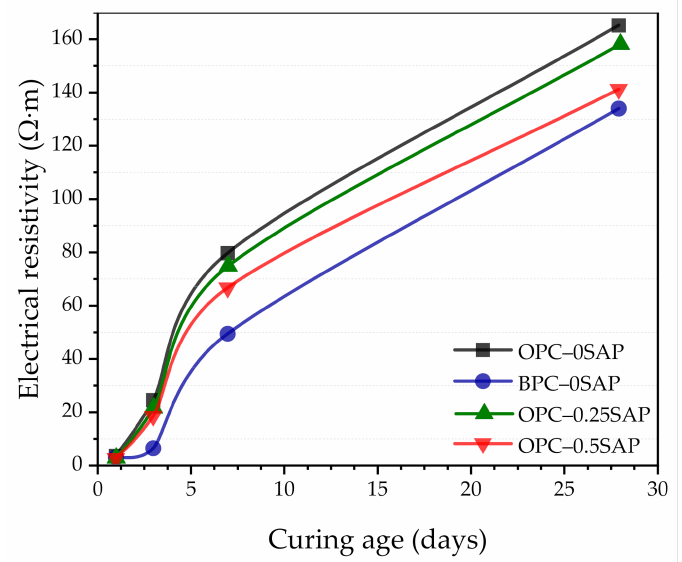
Figure 17. Changes in electrical resistivity of samples at different curing